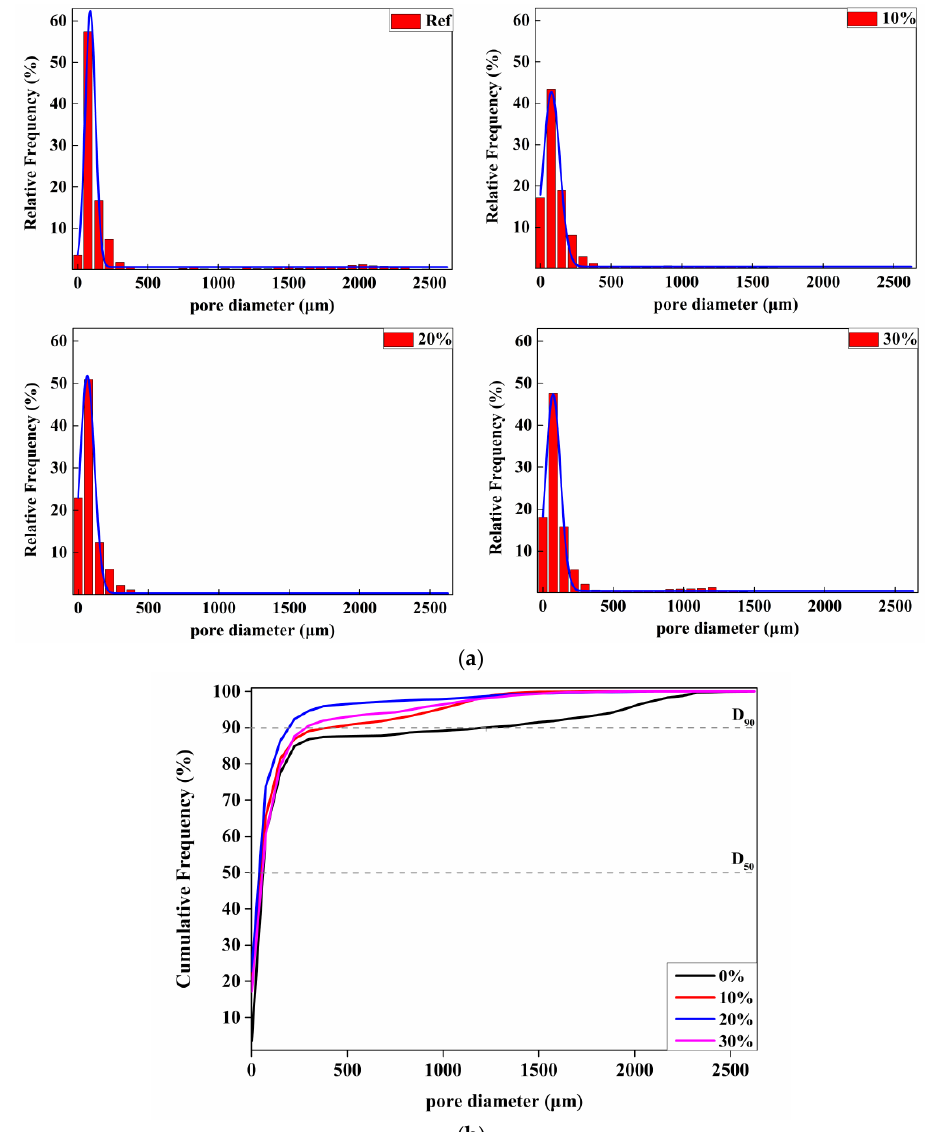
Figure 9. Pore size analysis: ( a ) pore size distributions of the foamed concretes; ( b ) cumulative frequency distributions of pore size.